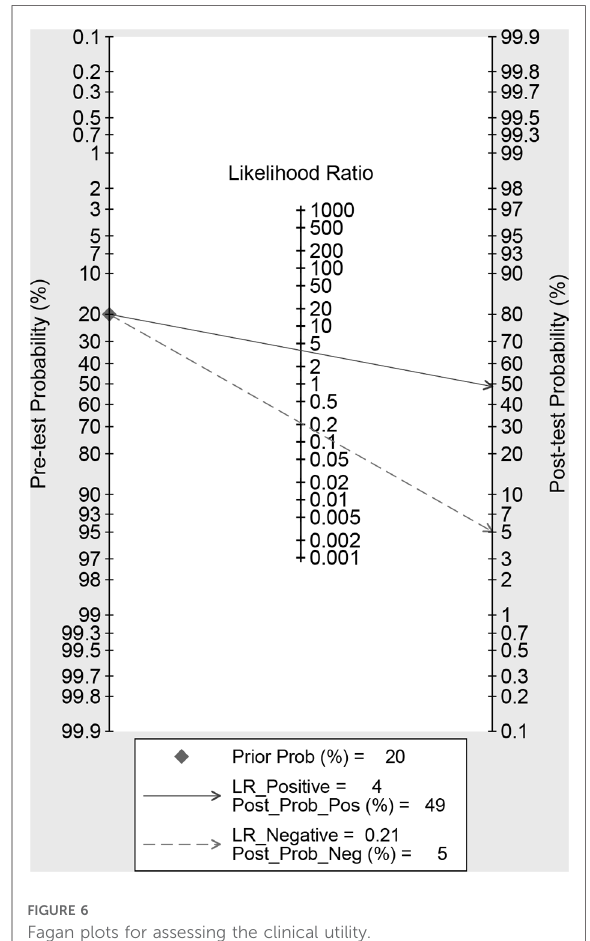
FIGURE 6 Fagan plots for assessing the clinical